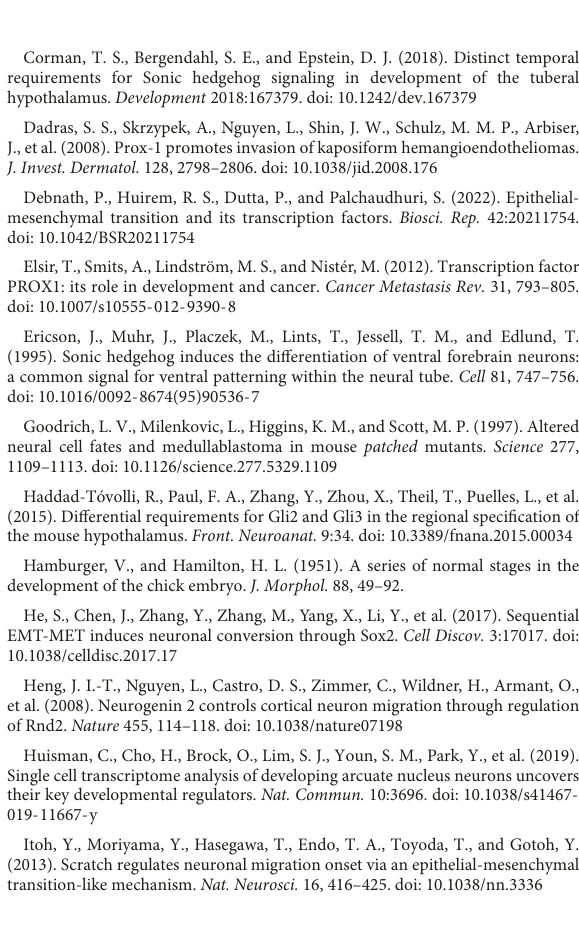
represent the number of explants staining positively (purple) or negatively (white) for the marker of interest, in control (left) and treatment (right)